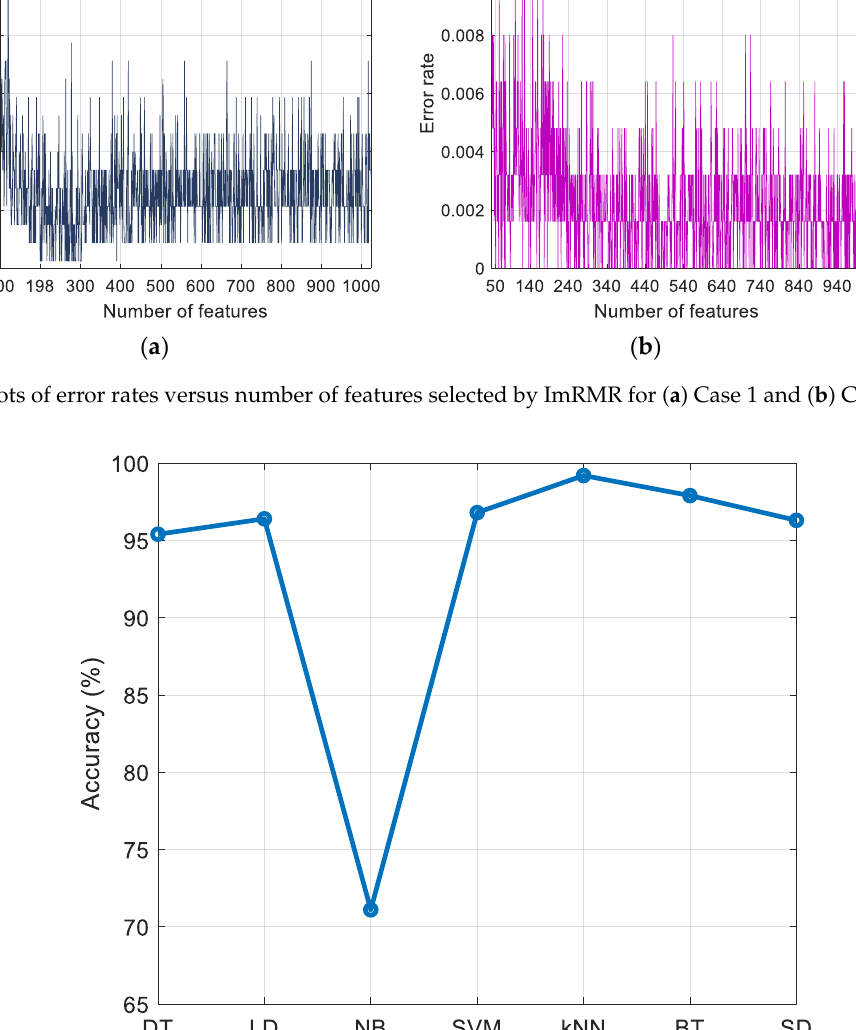
Figure 7. Plots of error rates versus number of features selected by ImRMR for ( a ) Case 1 and ( b ) Case 2.